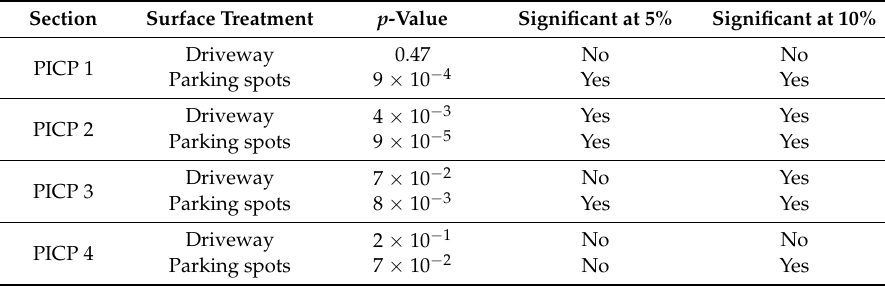
Table 11. Comparison of different pavement usage characteristics.